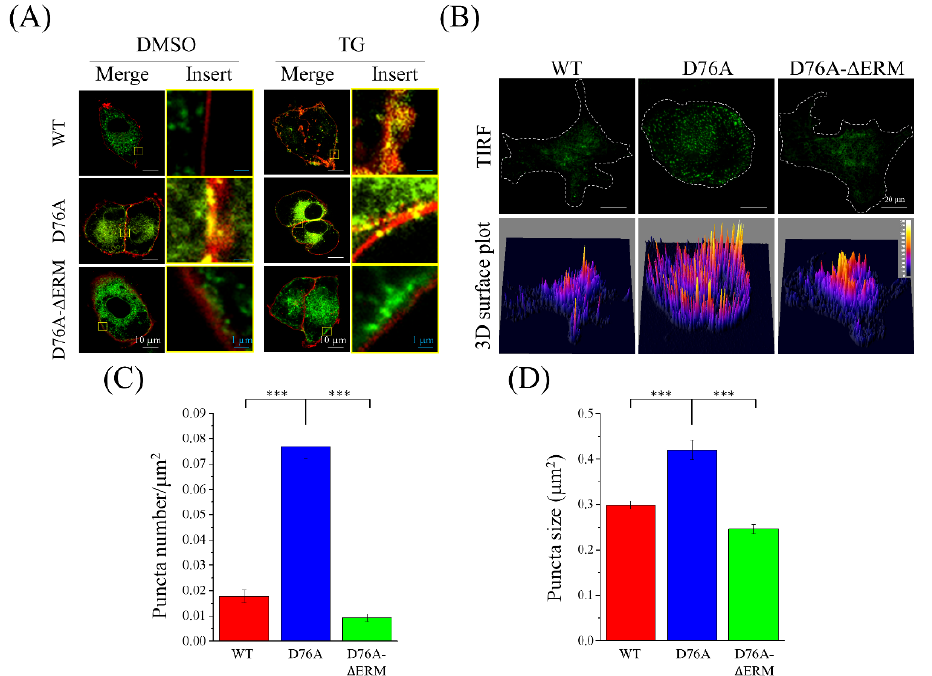
Figure 2. Localization of STIM1 variants on the plasma membrane. ( A ) The plasma membrane marker, ChR2-mCherry, was transiently transfected into the cells. Then, the cells were treated with dimethyl sulfoxide (DMSO) or 2 µ M TG to trigger the SOCE response. Representative confocal images were shown with fixed exposure time. Green, STIM1; red, ChR2. ( B ) Upper panel: representative TIRF images were taken without Ca 2+ depletion in the endoplasmic reticulum (ER). White dotted line represents the boundary of the cells. Lower panel: 3D surface plot of the fluorescent protein-tagged STIM1 variants in resting-state cells. ( C , D ) Quantification of number and size of STIM1 puncta from ( B ). n > 21 in every group. *** P < 0.001 by one-way ANOVA.